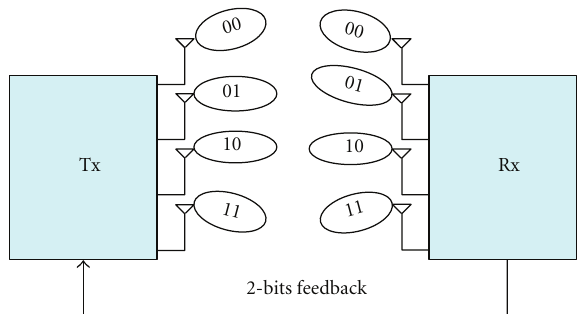
Figure 5: Illustration of applying two-bit feedback (Butler matrix) for 4 × 4 MIMO